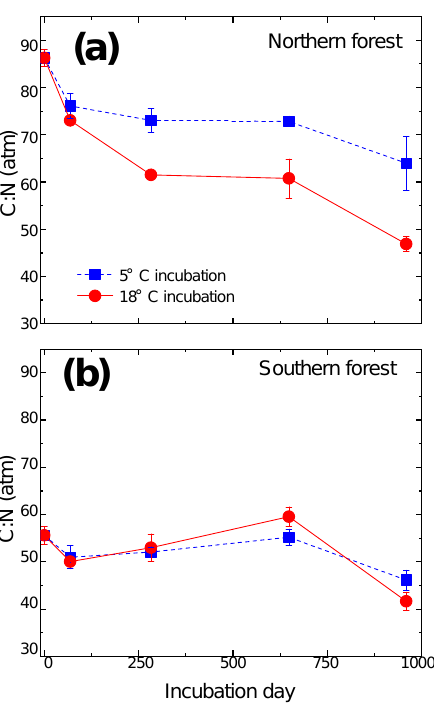
Figure 3. Molar carbon-to-nitrogen ratio of moss tissues from the cooler (a) and warmer (b) forest sites plotted against incubation time. Values for the 5 ◦ C and 18 ◦ C incubations temperatures are given by the blue squares and red circles, respectively, and are re- ported as the mean ( n = 3), with standard error depicted by error bars.